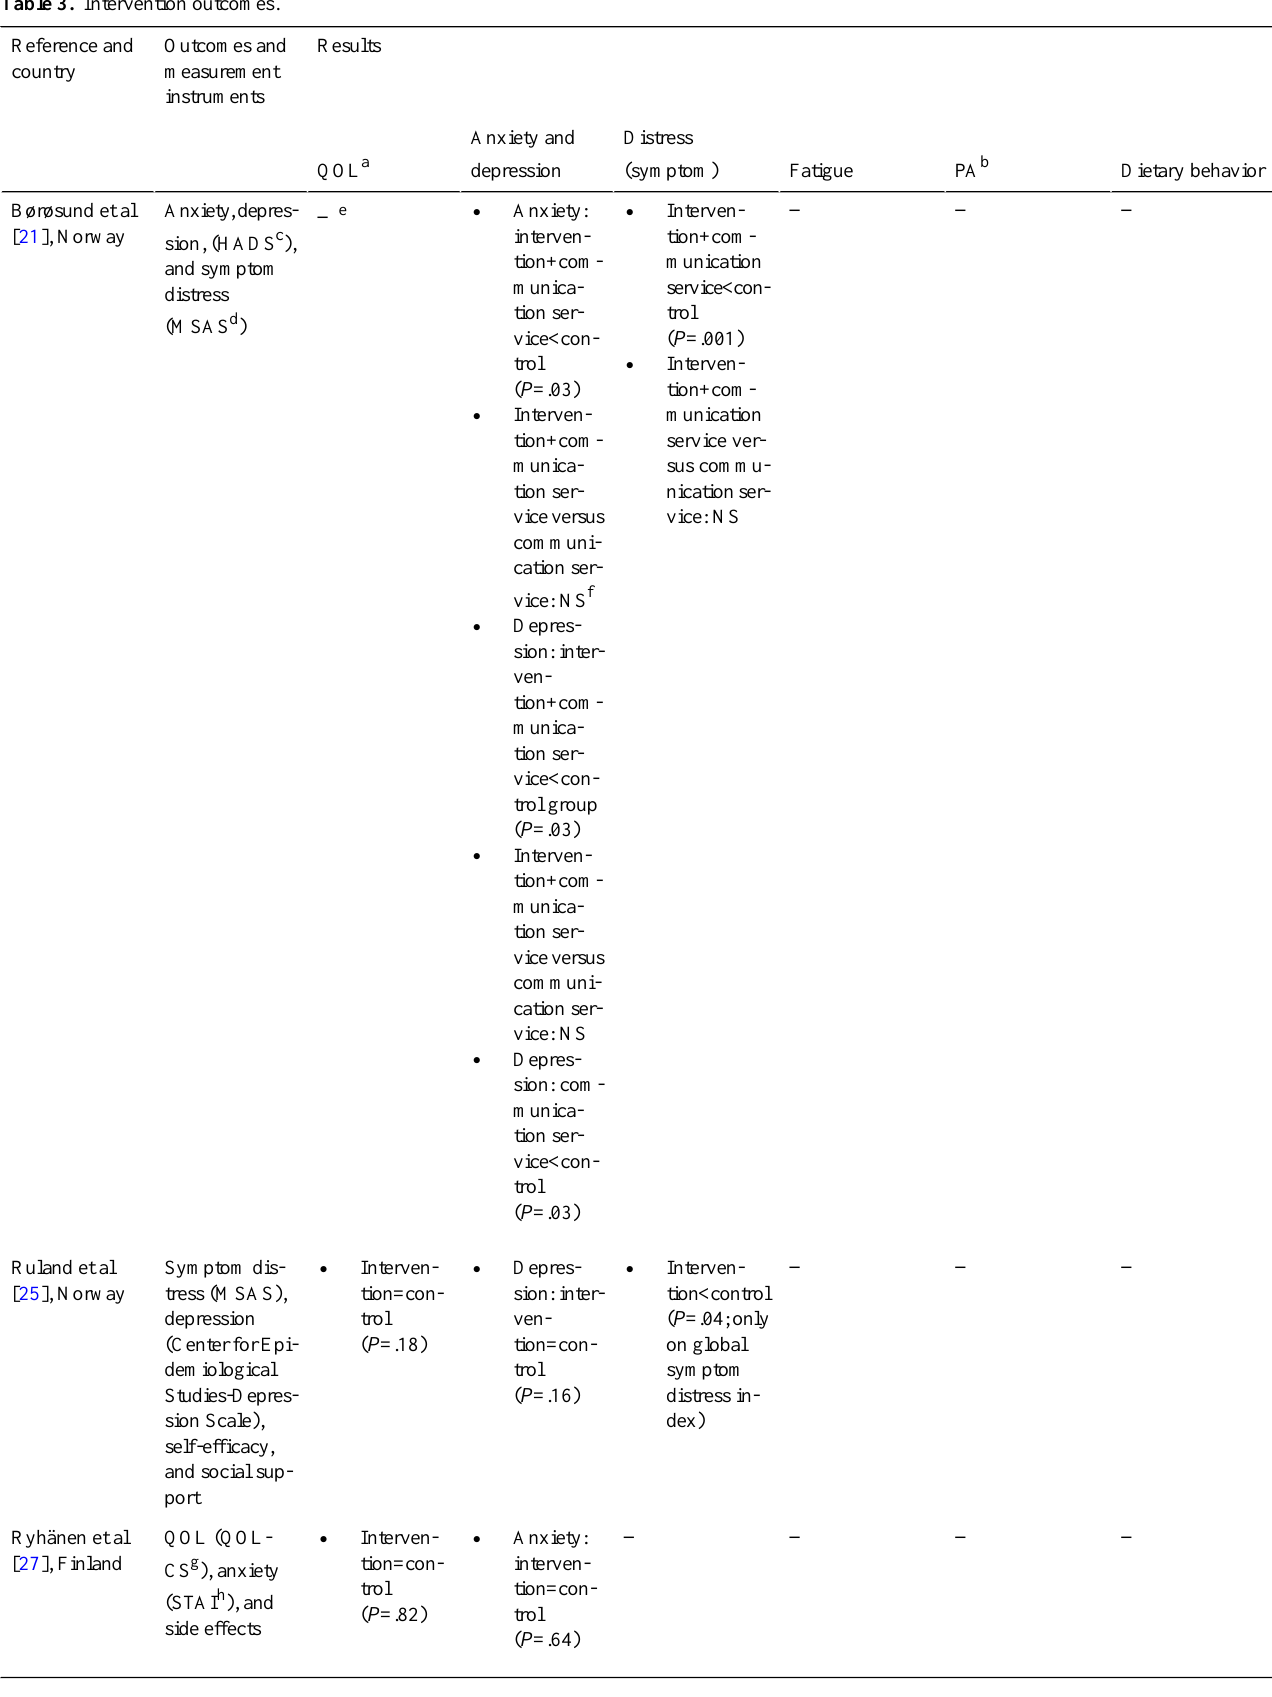
Table 3. Intervention outcomes. ResultsOutcomes